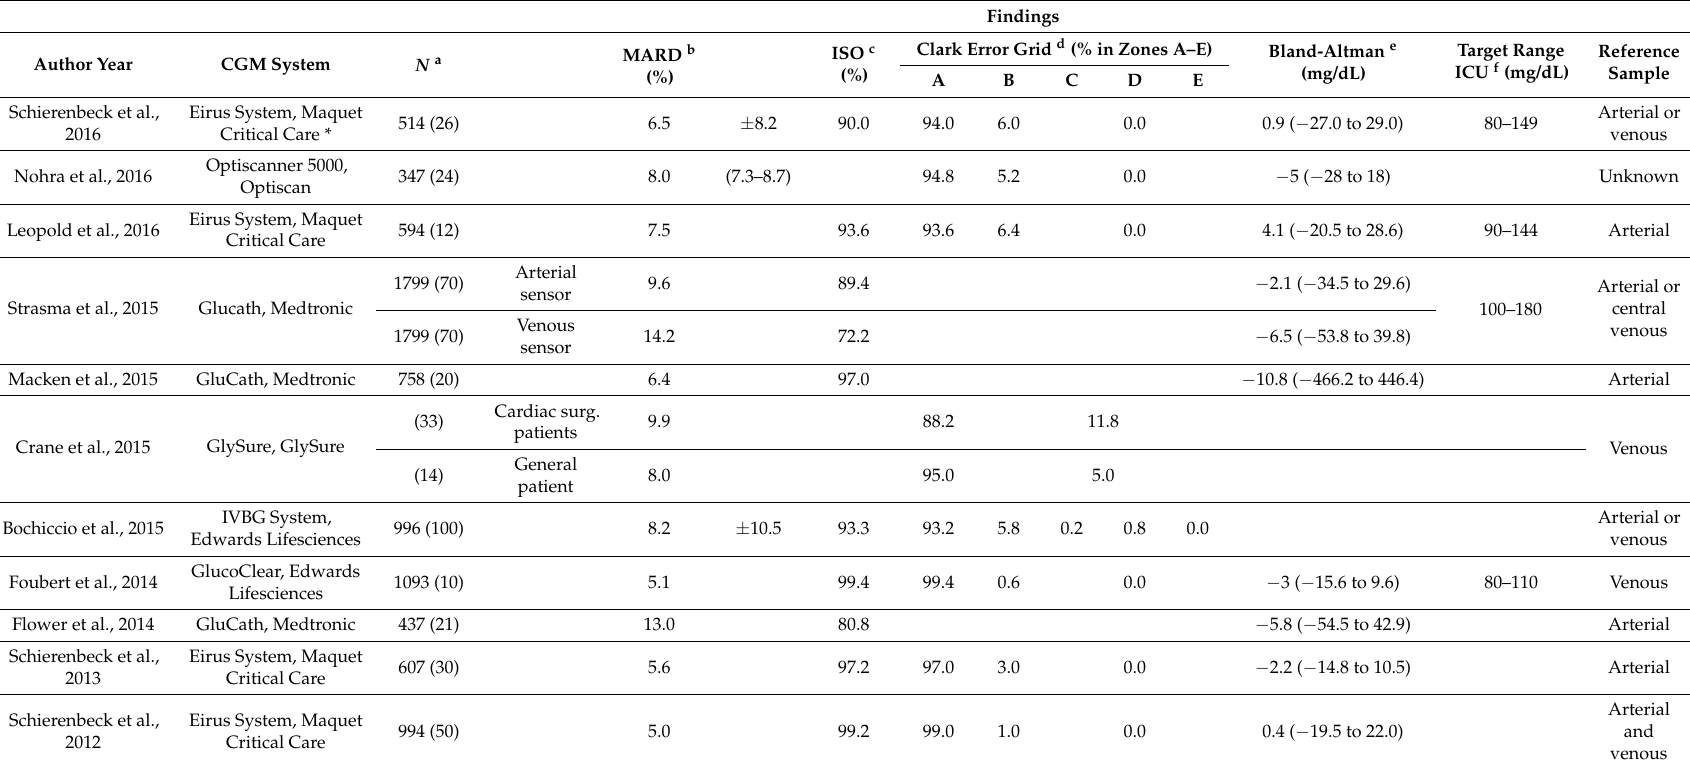
Table 4. Reported accuracy outcomes of the included studies that assessed intravascular CGM systems ( n =